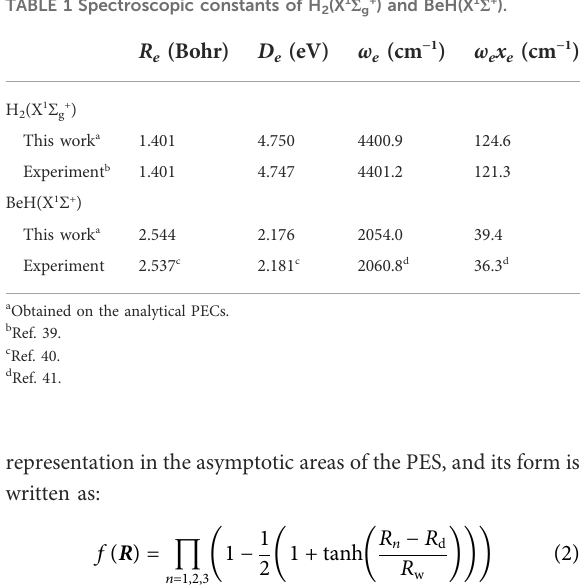
TABLE 1 Spectroscopic constants of H 2 (X 1 Σ g + ) and BeH(X 1 Σ + ).